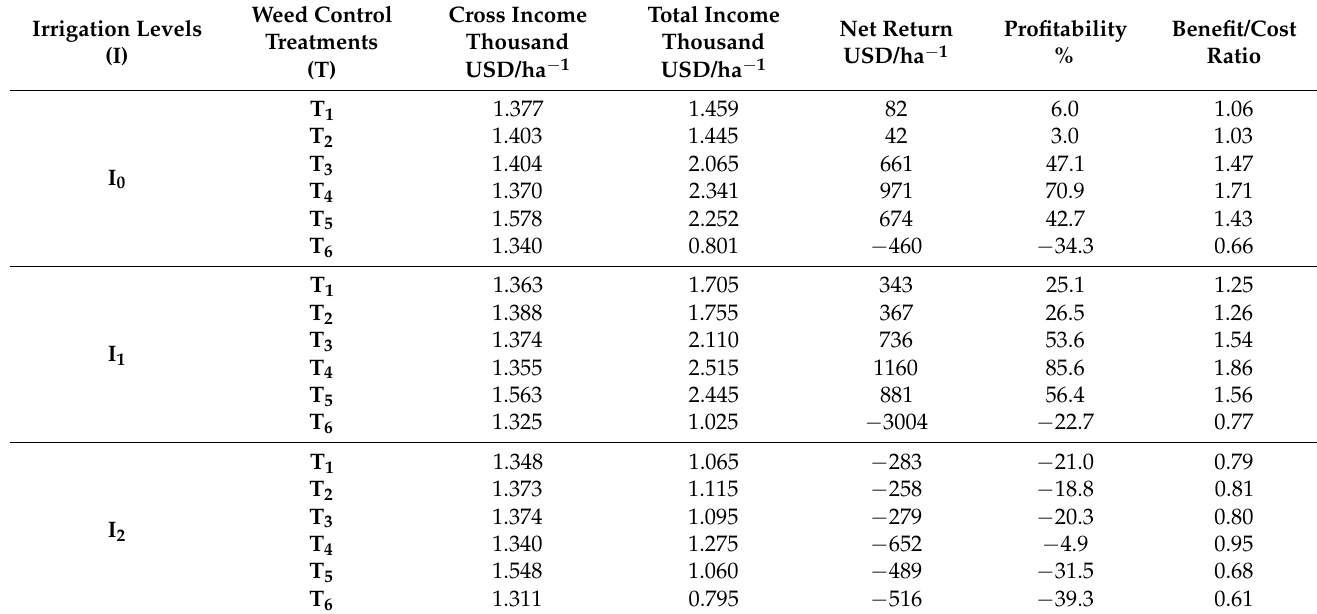
Table 12. Effect of interaction between irrigation levels and weed control treatments on economic evaluation of soybean crop (combined data from 2019 and 2020